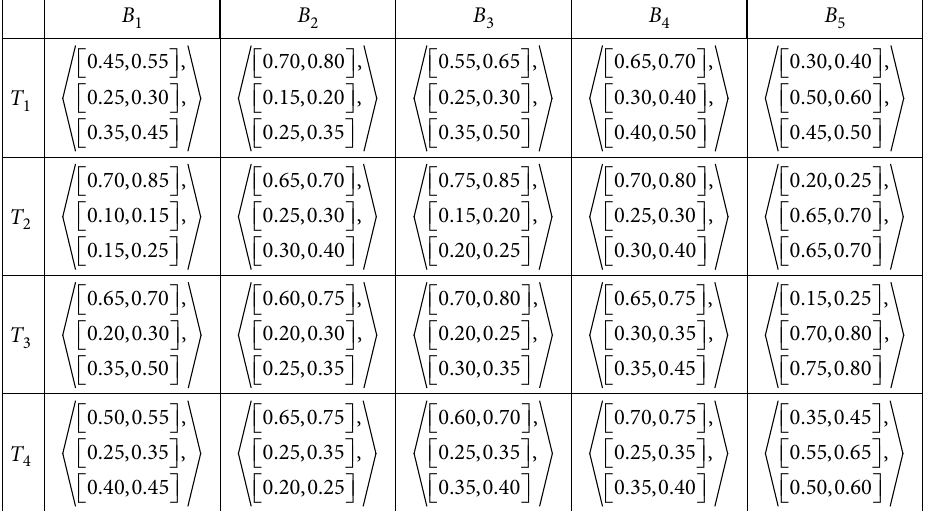
Table 1. Decision